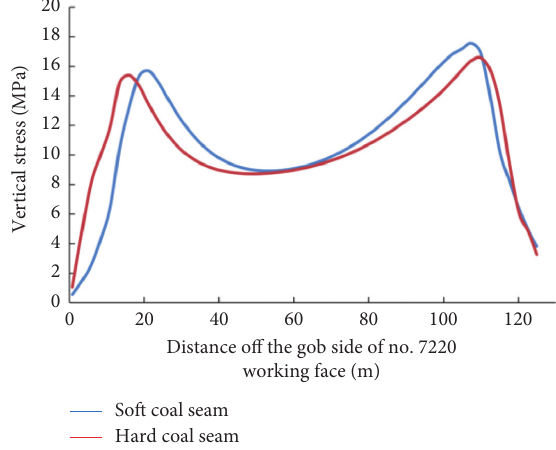
Figure 8: Distribution curve of vertical stress in gob sides in the island longwall